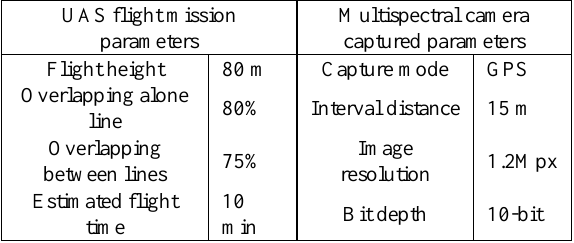
Table 1. Parameters set for UAS flight mission and multispectral camera